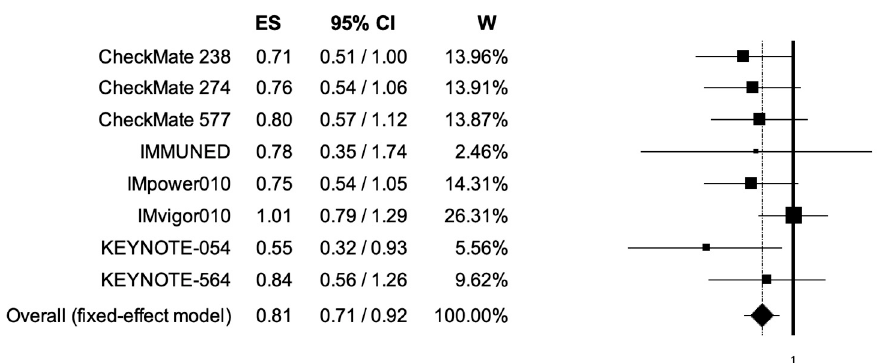
Cancers 2022 , 14 , 4142 7 of 10 Figure 6. Forest plot of comparison between adjuvant PD-1 and PD-L1 inhibitors versus control (placebo/ipilimumab/observation/best supportive care) in cancer patients; the outcome of interest was relapse-free survival (RFS) in younger patients. Abbreviations: CI: confidence interval; ES: effect size; and W: weight.